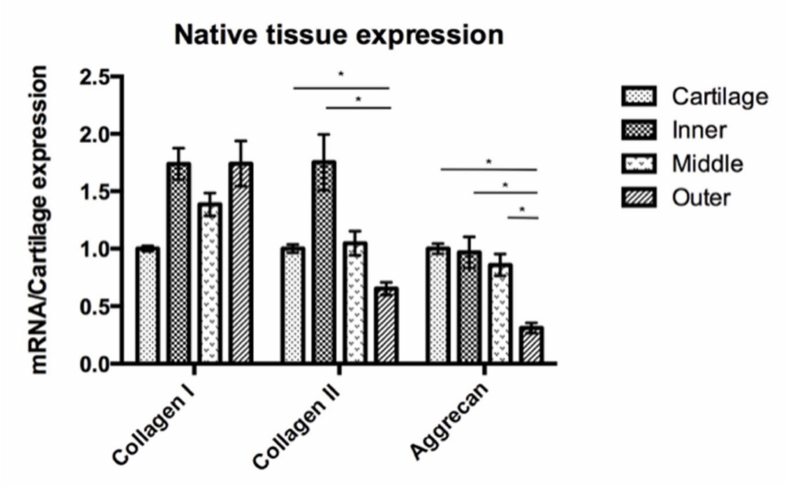
Figure 7. Native cartilage and meniscus tissue expression with the COL1A1, COL2A1 and ACAN gene expression of the meniscus is presented in comparison to the cartilage gene expression. The expression of COL2A1 was higher in the cartilage and inner meniscus compared to the outer meniscus, but there were no significant differences between the cartilage and the inner and middle meniscus. For ACAN, the outer meniscus had the lowest expression, and there were no significant differences among the other three groups. *: p -value <